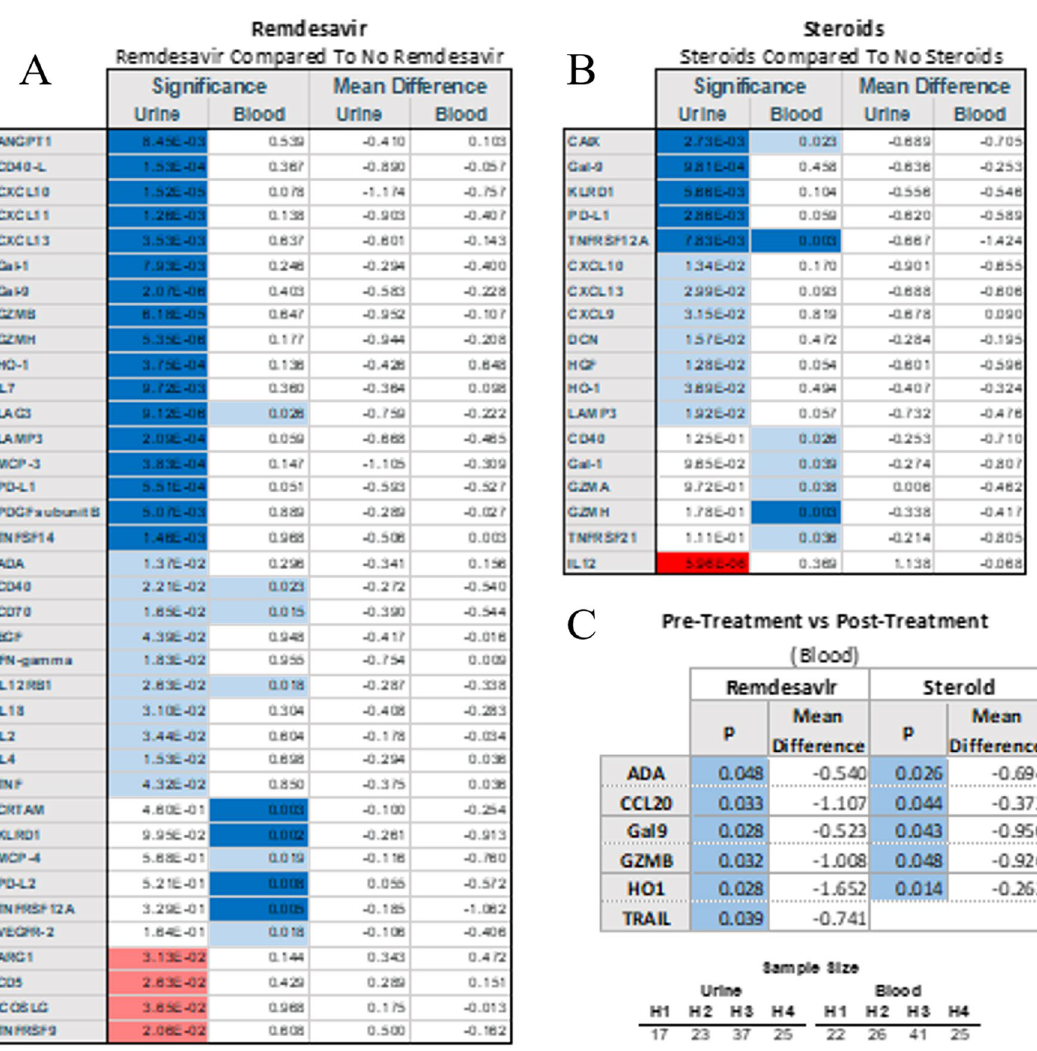
Figure 7. Remdesivir ( A ) was correlating with much more dynamic activation pattern than steroids ( B ) judging from presence of the urinary markers in urine. Only few markers in blood were changed after introduction of remdesivir or steroids ( C